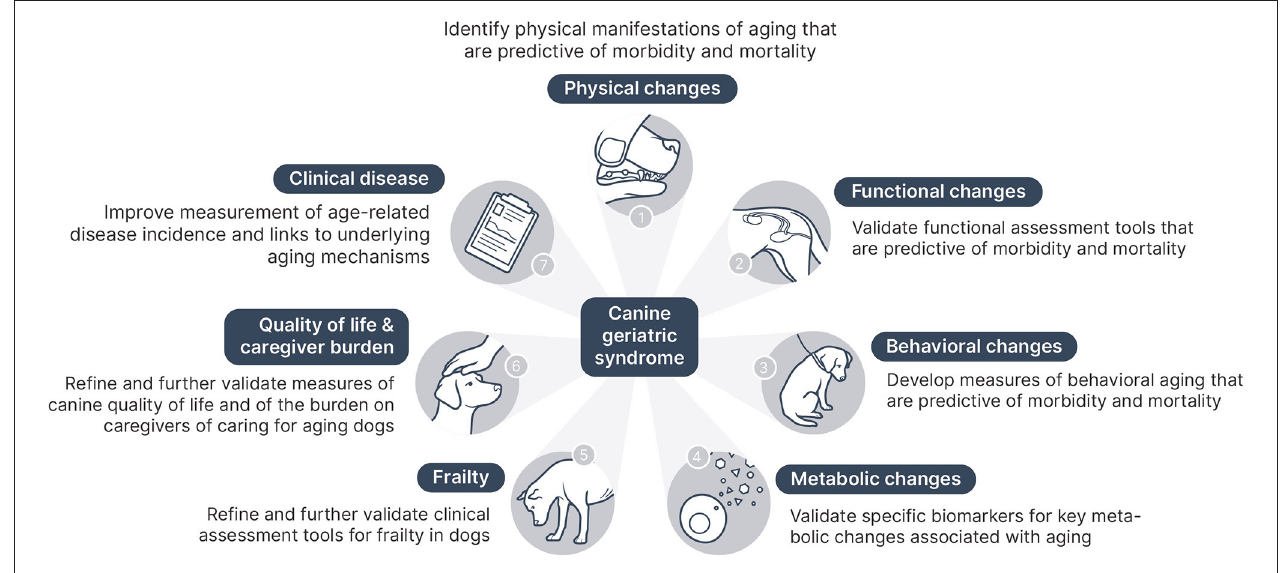
FIGURE 1 | Next steps for developing the components of canine geriatric